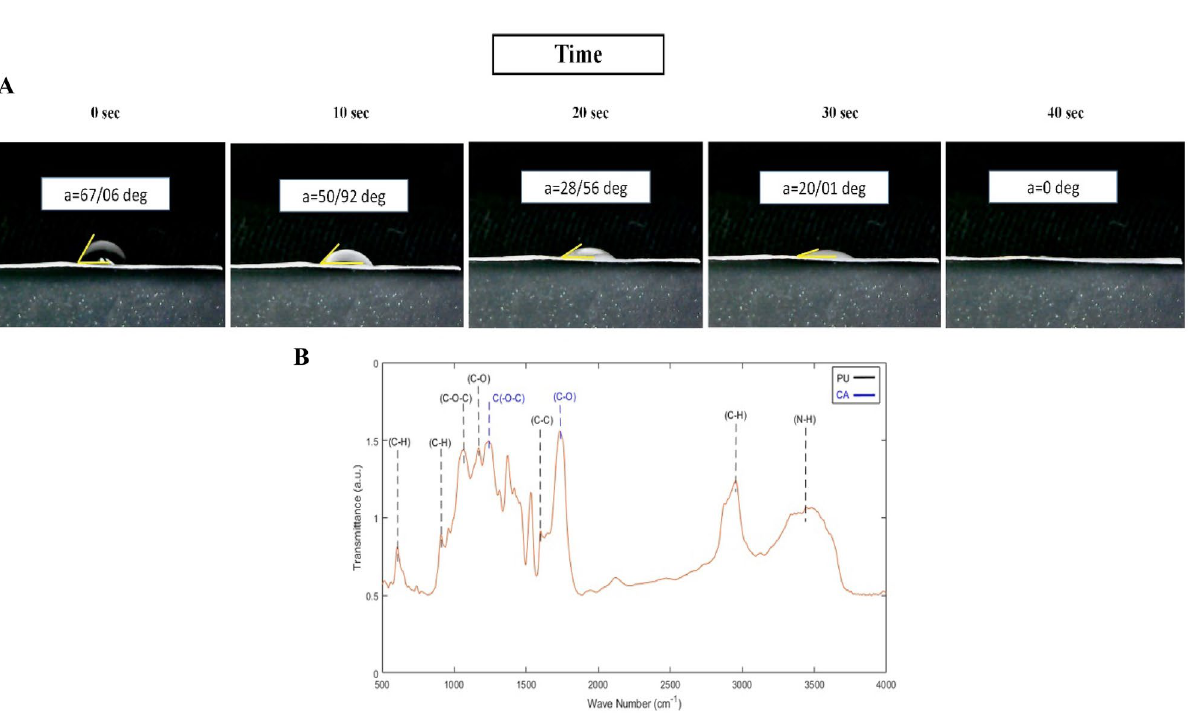
Figure 5. ( A ) Contact angle measurements of PU-CA scaffold and (B) FTIR spectra of PU-CA scaffold that black and blue dashed line shows PU and CA peaks,